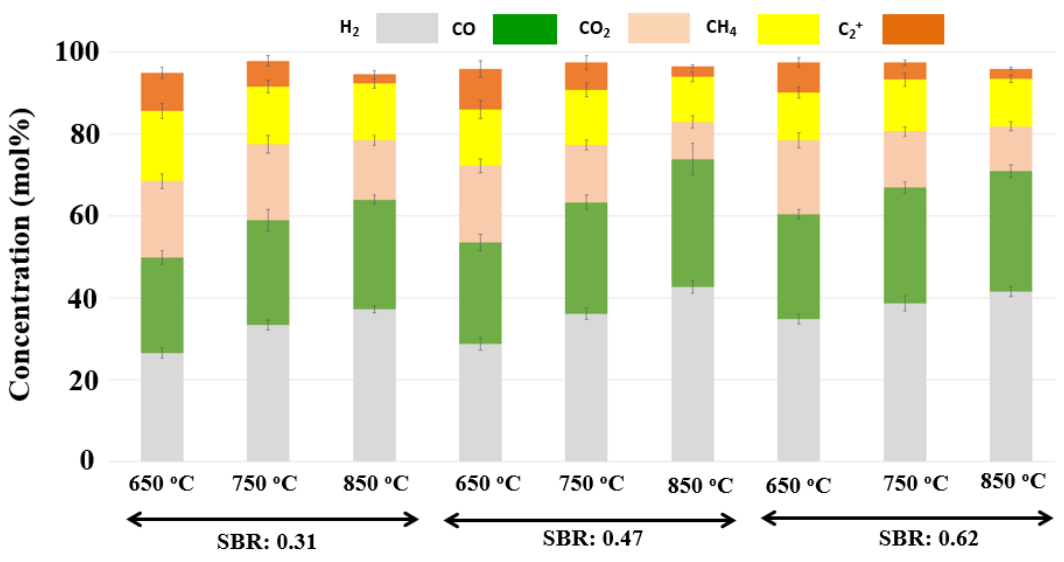
Figure 1. Gas product composition for the steam gasification process at different process temperatures and SBR values.